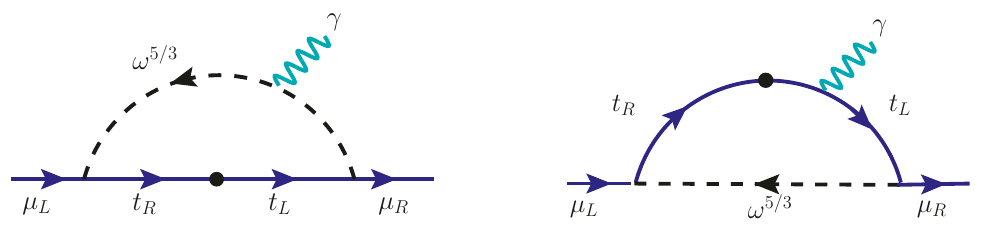
Figure 4 . Chirally-enhanced contribution from the R 2 LQ to the muon anomalous magnetic